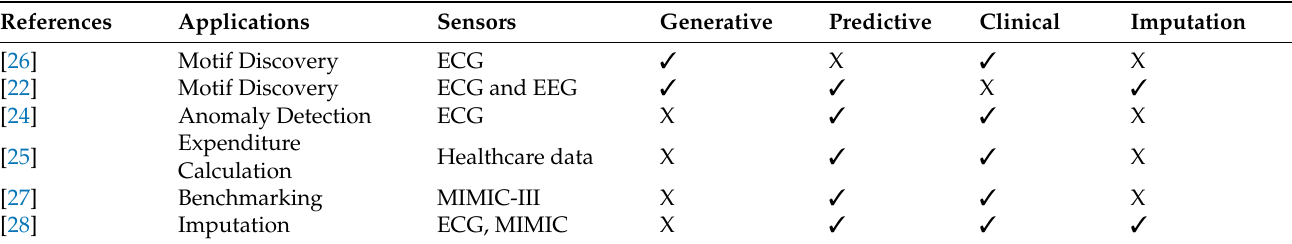
Table 2. Comparison of the time-series